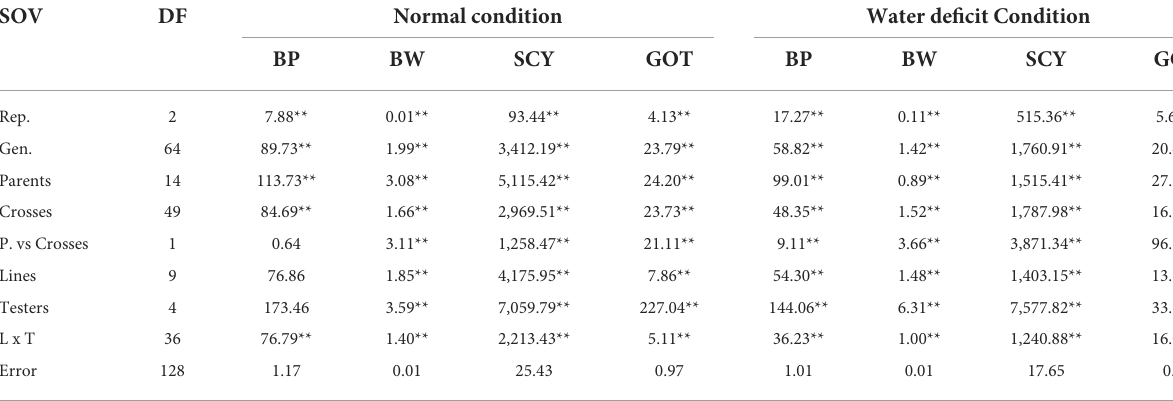
TABLE 3 Mean square values of line × tester analysis for various traits under normal and water deficit condition. SOV DF Normal condition Water deficit Condition